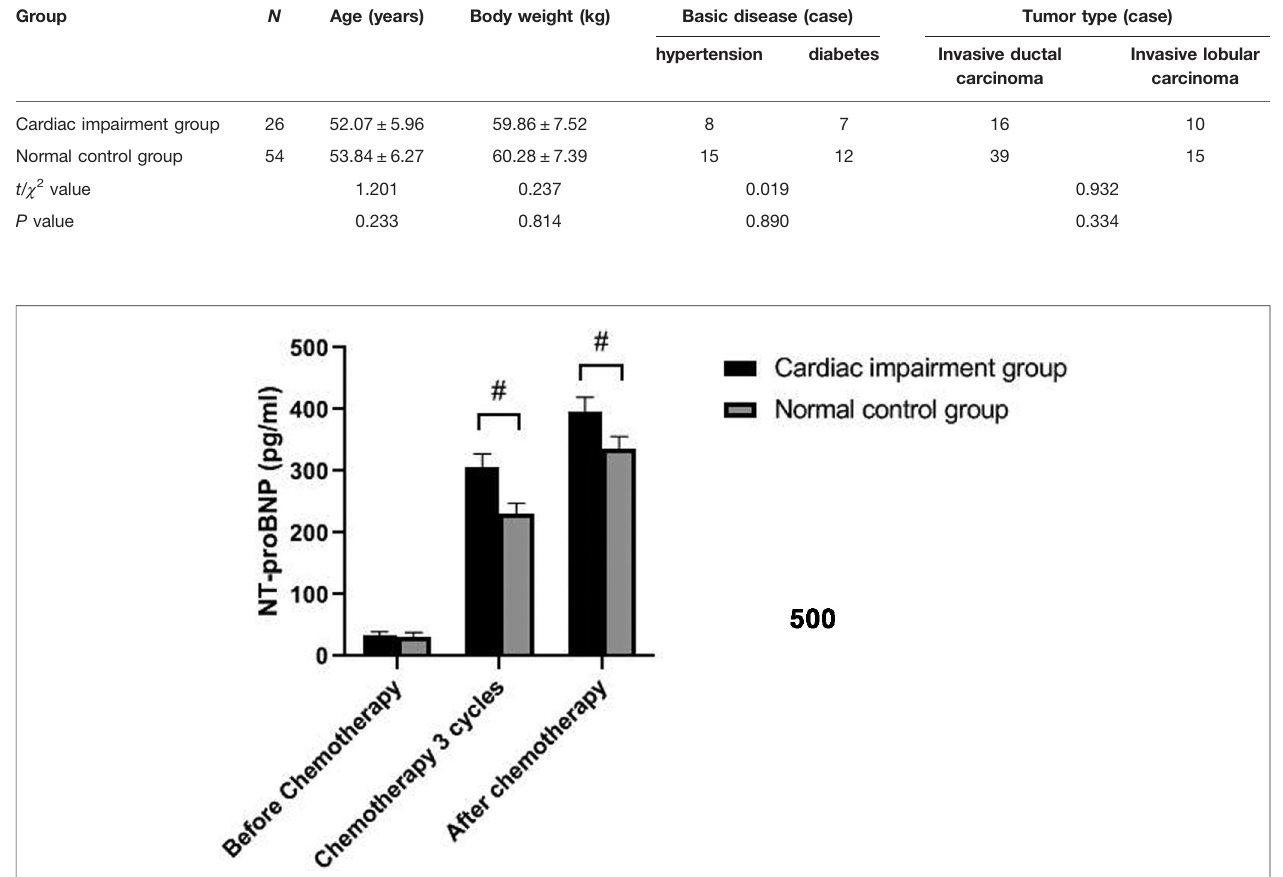
TABLE 1 | Comparison of general data between the two groups.